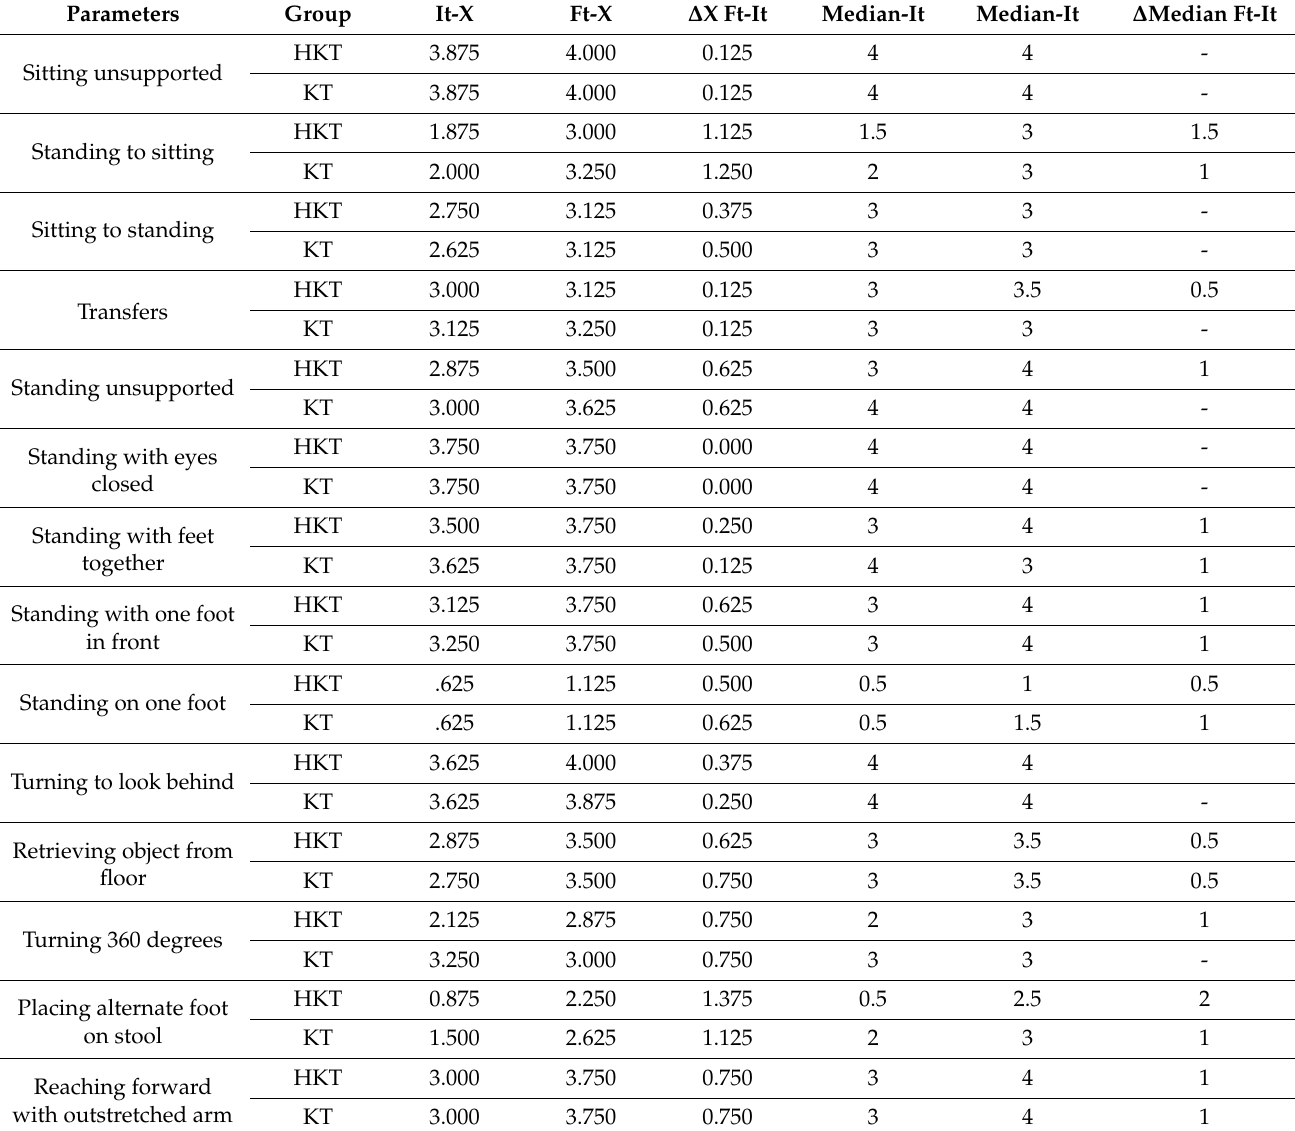
Table 2. Statistical analysis of Berg Scale task